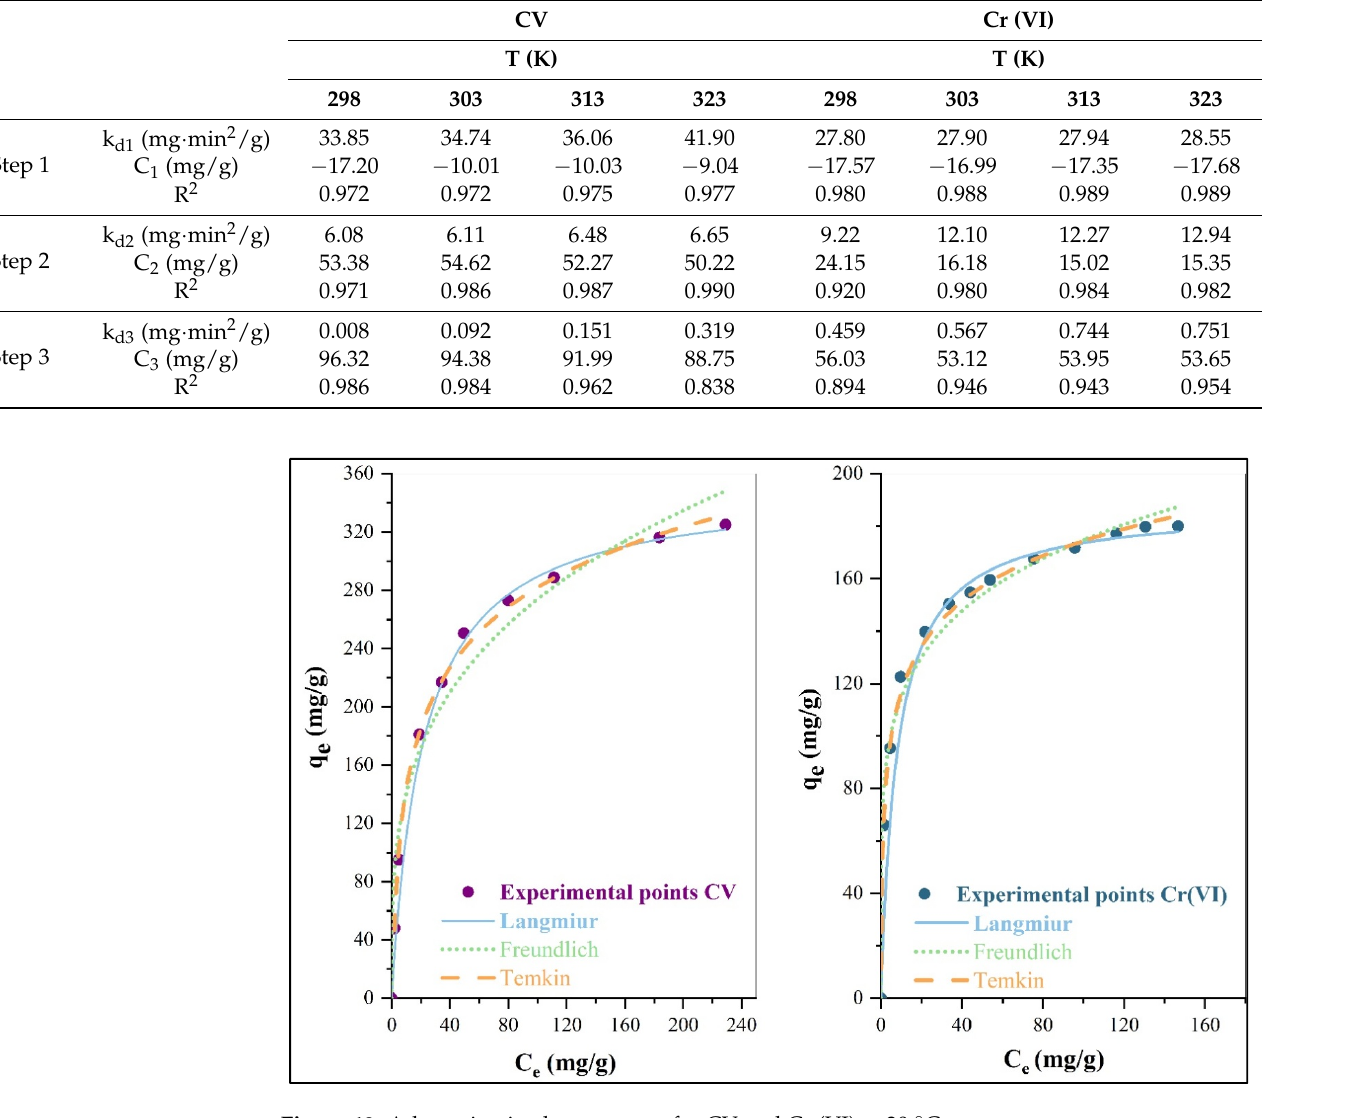
Table 5. Constants of the intraparticle diffusion model.